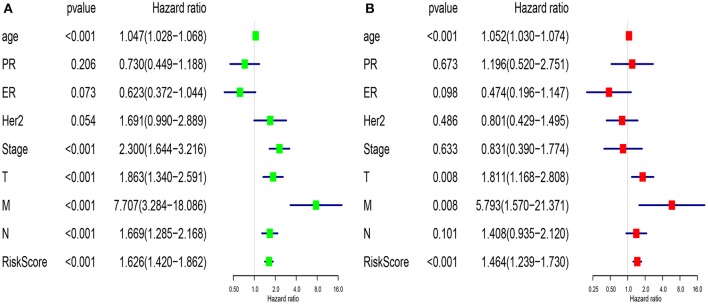
Univariate (A) and multivariate (B) analysis of clinic pathologic factors for overall survival of breast cancer patients from TCGA.